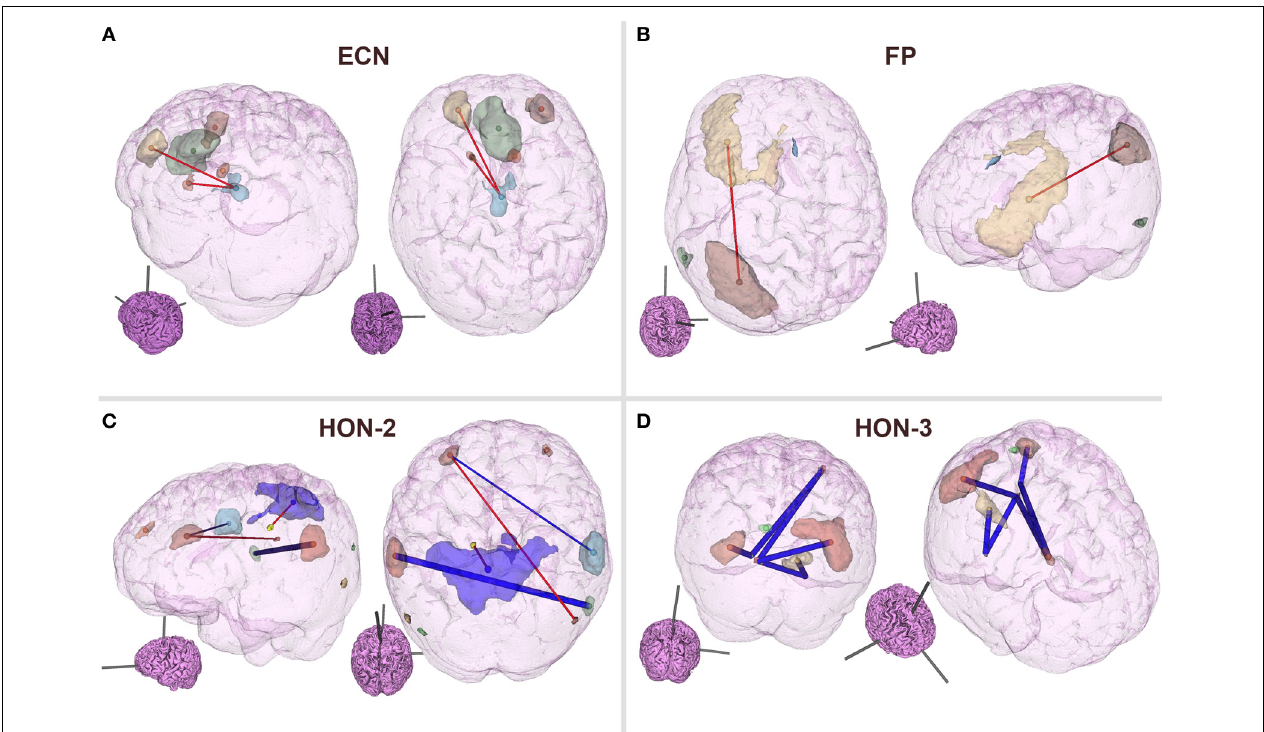
FIGURE 3 | Features maximally contributing to SVM classification performance. Features that were utilized in the within-RSN classifier following 90% feature elimination on 15 or more runs of LOOCV were identified, and these consisted of circuits within the (A) ECN, (B) FP, (C) HON-2, and (D) HON-3. Red and blue lines indicate circuits in which